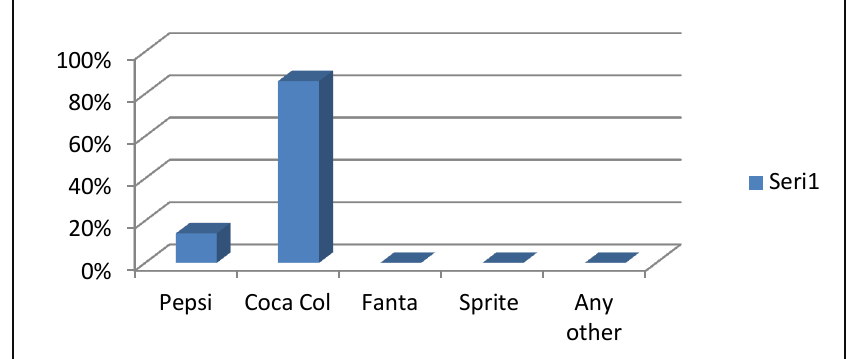
Figure 11: Which Drink is easily available near your